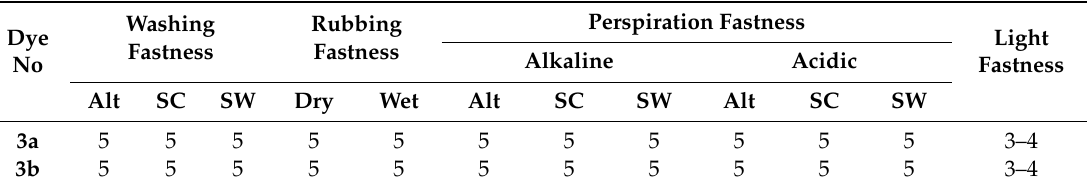
Table 3. Fastness properties of azo disperse dyes on polyester